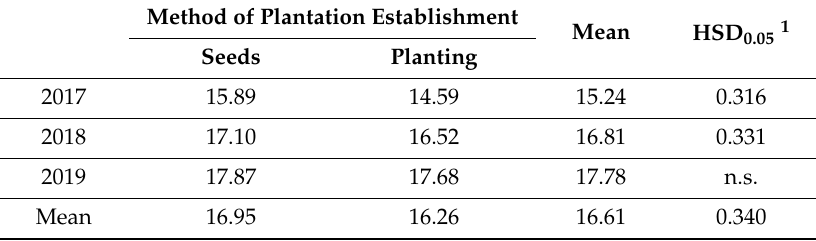
Table 11. The calorific value of Silphium biomass (MJ kg − 1 ), depending on methods of plantation